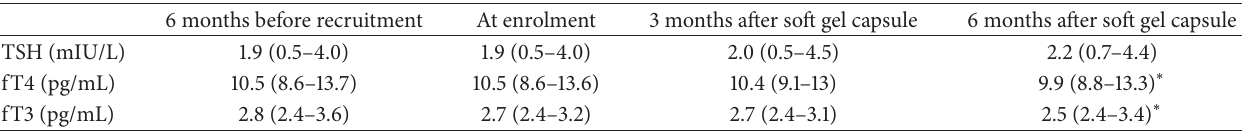
Table 3: Thyroid hormone levels six months before recruitment and at enrolment (both when taking liquid L-T4) and after 3 and 6 months’ treatment with L-T4 soft gel capsules ( 𝑛 = 30